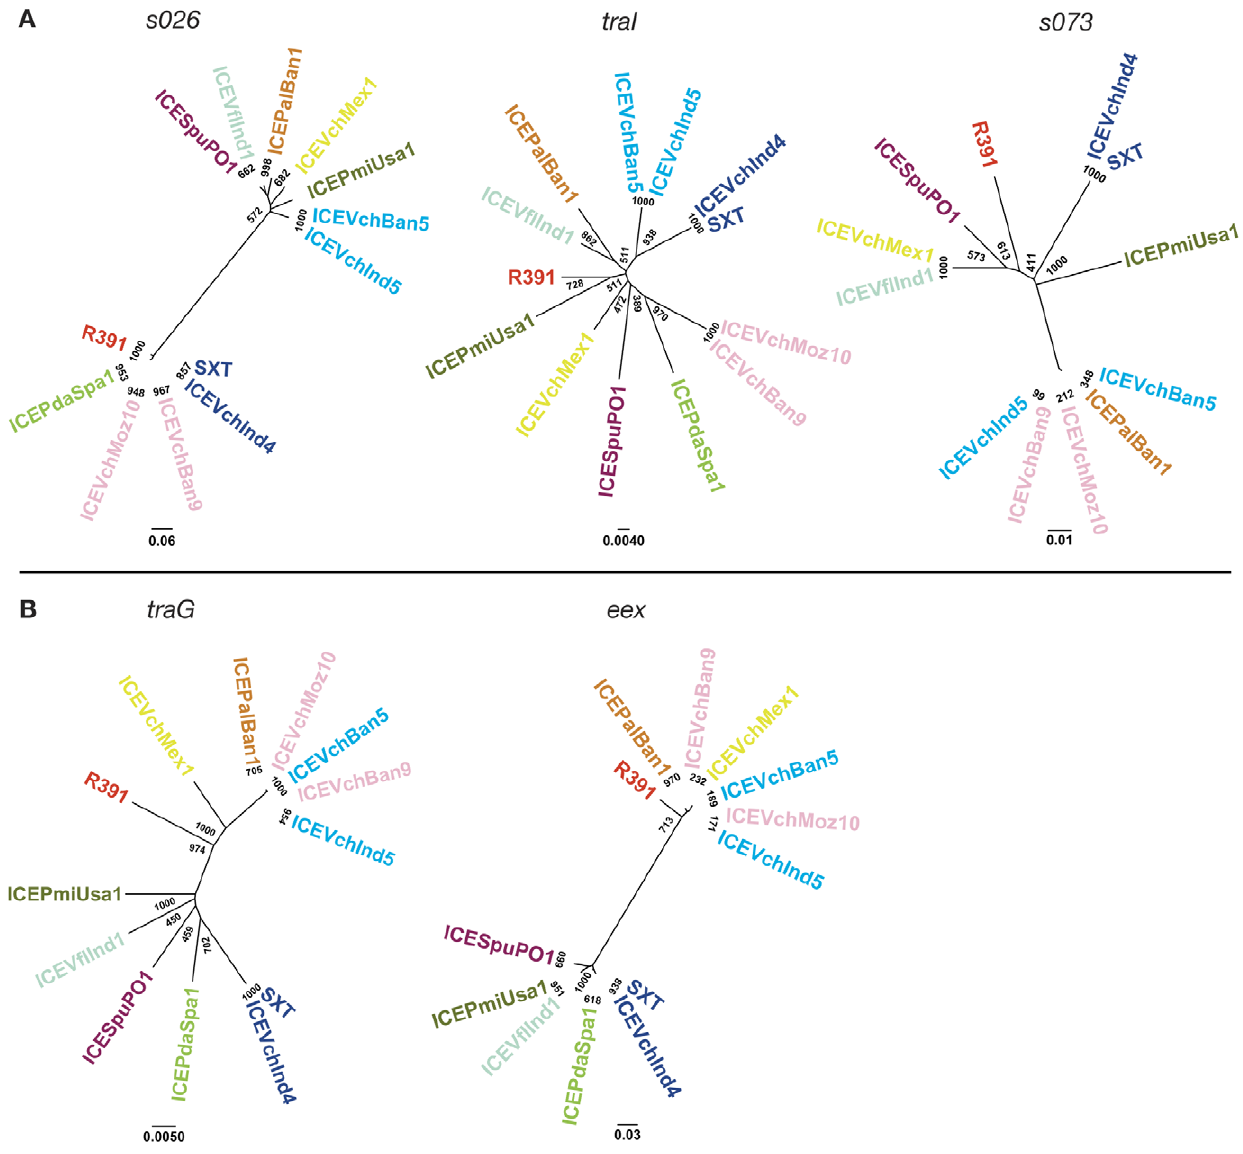
Figure 6. Phylogenetic analysis of several core ICE genes. Nucleotide sequences of the indicated core genes were used to generate the phylogenetic trees shown. Bootstrap values are indicated at branch points. The individual scale bars represent genetic distances and reflect the number of substitutions per residue.